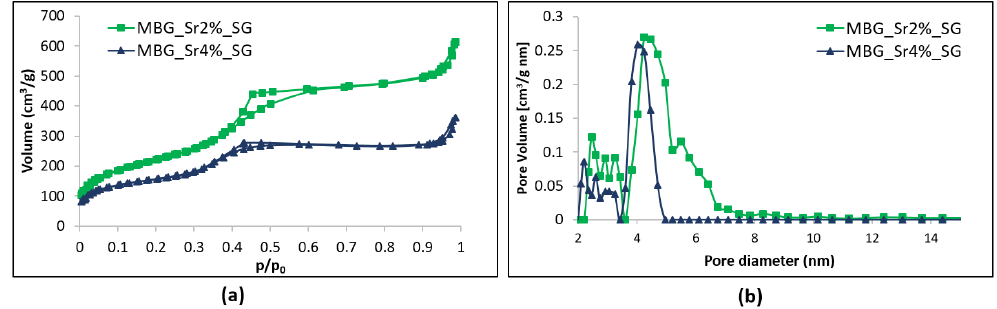
Figure 2. N 2 adsorption-desorption curves of MBG_Sr2%_SG and MBG_Sr4%_SG: ( a ) isotherms; ( b ) DFT pore size distributions.